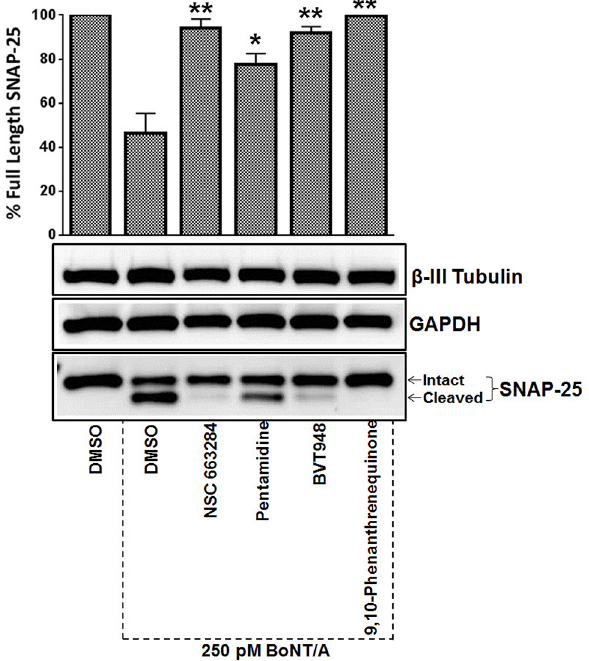
Fig 1. Mouse ES-derived motor neuron based assays identify phosphatase inhibitors as BoNT/A antagonists. Four phosphatase inhibitors identified as potential BoNT inhibitors in imaging based assays were analyzed in secondary screens using mES-MNs to confirm their protective activities against BoNT/A. mES-MNs were incubated with 20 μ M compound for 30 minutes and then treated with 250 pM BoNT/A for 4 hrs. BoNT/A activity was measured by Western blot analysis and band densitometry. GAPDH and neuron specific β -III tubulin (Tuj1) served as loading controls. Error bars represent standard error of means (n = 3). $$ , $ Value significant at 99% and 95% confidence level, respectively, compared to DMSO+Toxin control conditions (Student ’ s t-